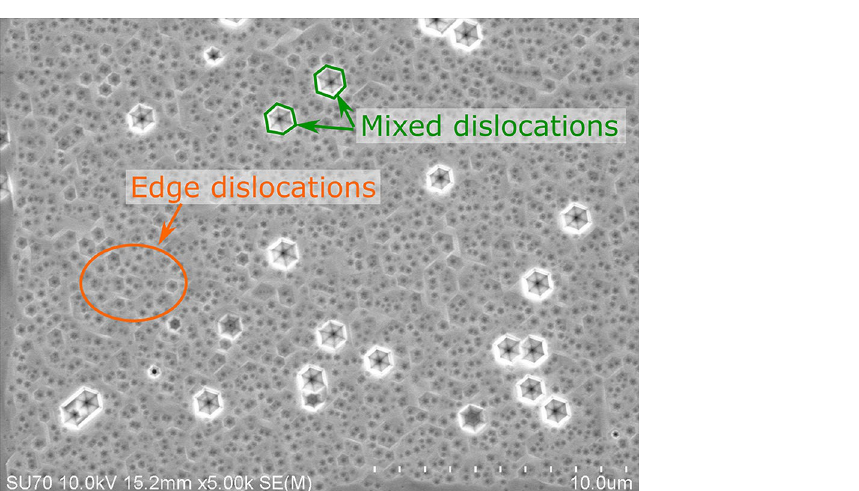
Figure 10. SEM picture of etched laser diode